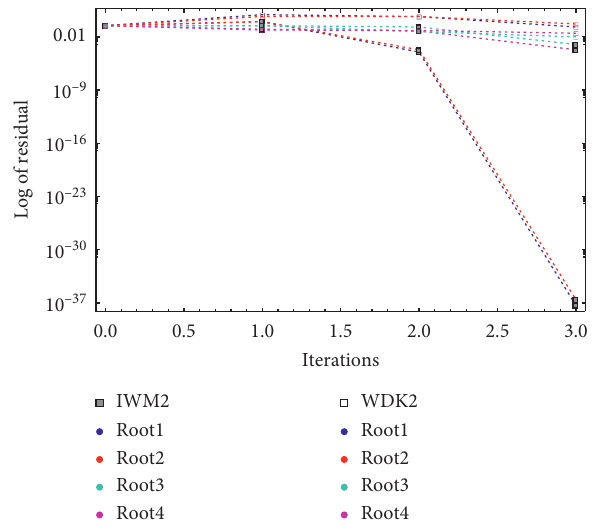
( r ) , respectively. 5